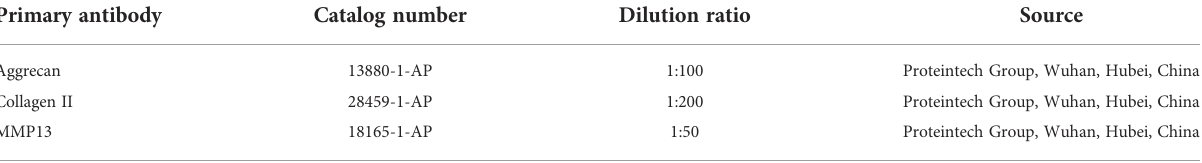
TABLE 2 Primary antibodies for immuno fl uorescence cell staining. Primary